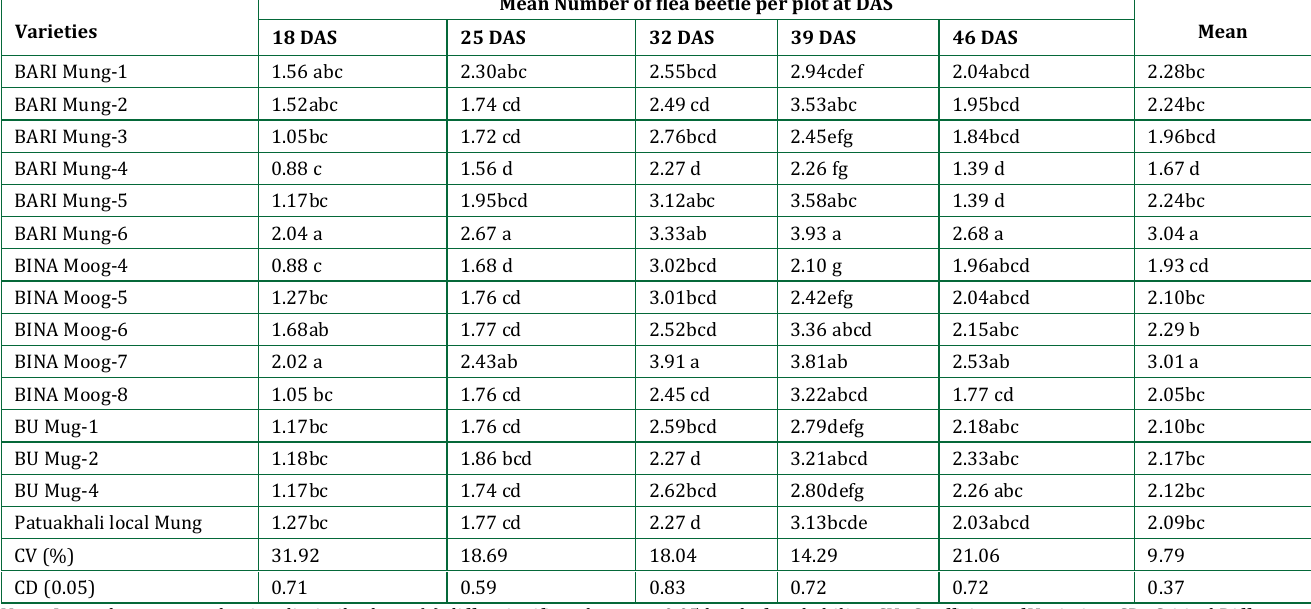
Table 1: Mean number of flea beetle per plot on different mungbean varieties Mean Number of flea beetle per plot at DAS Varieties